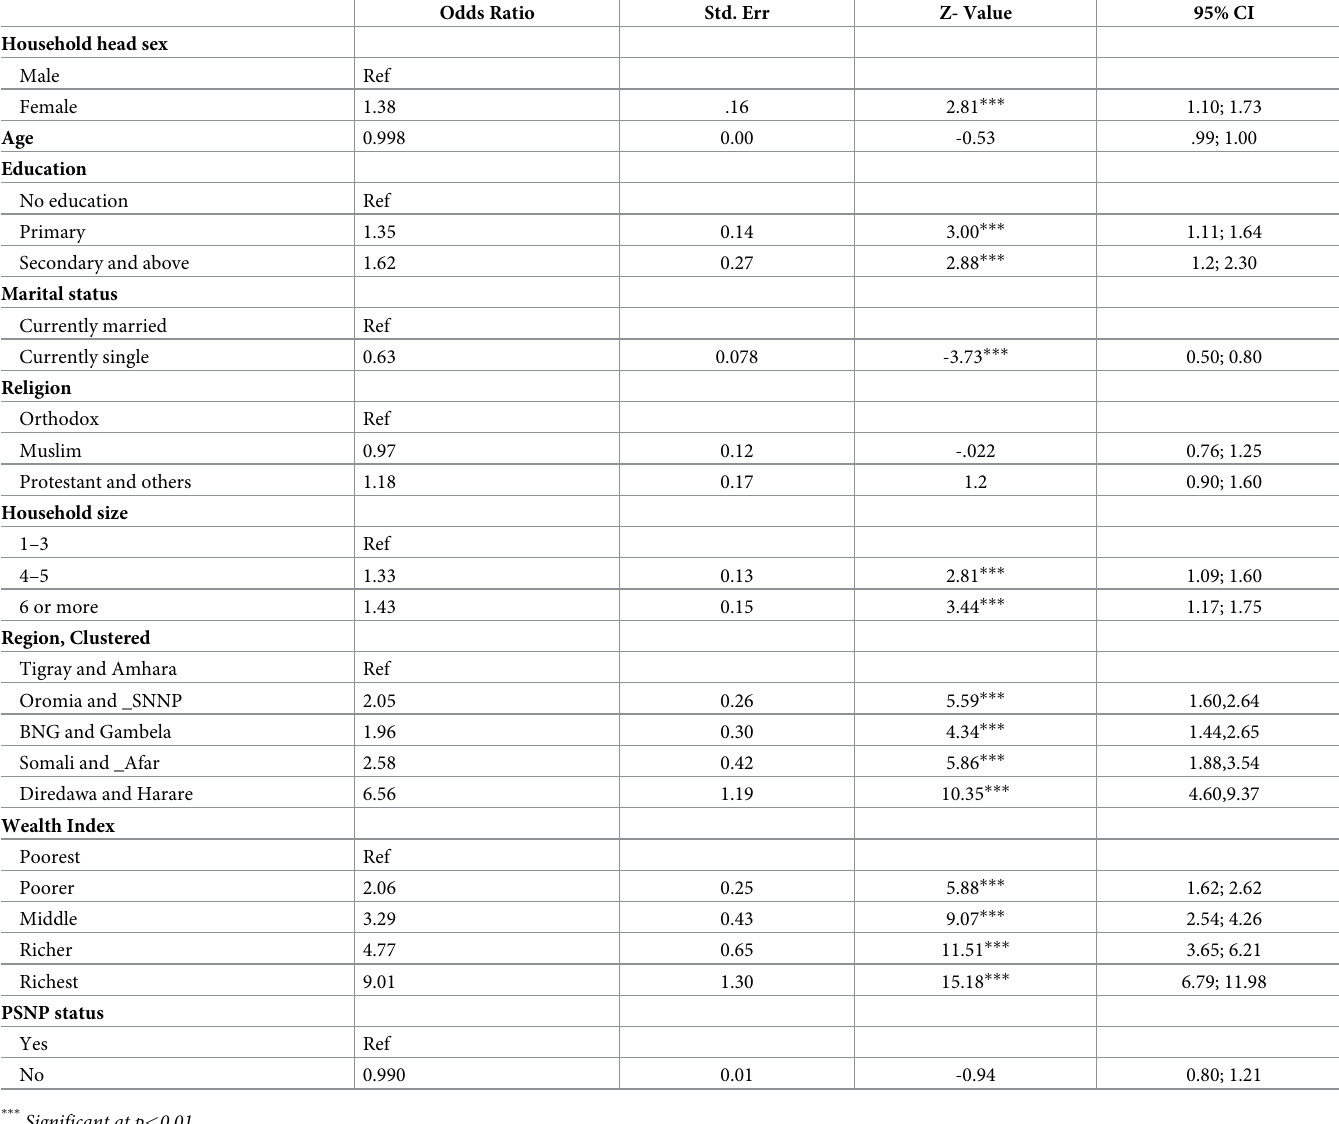
Table 3. Estimation results of the ordered logit